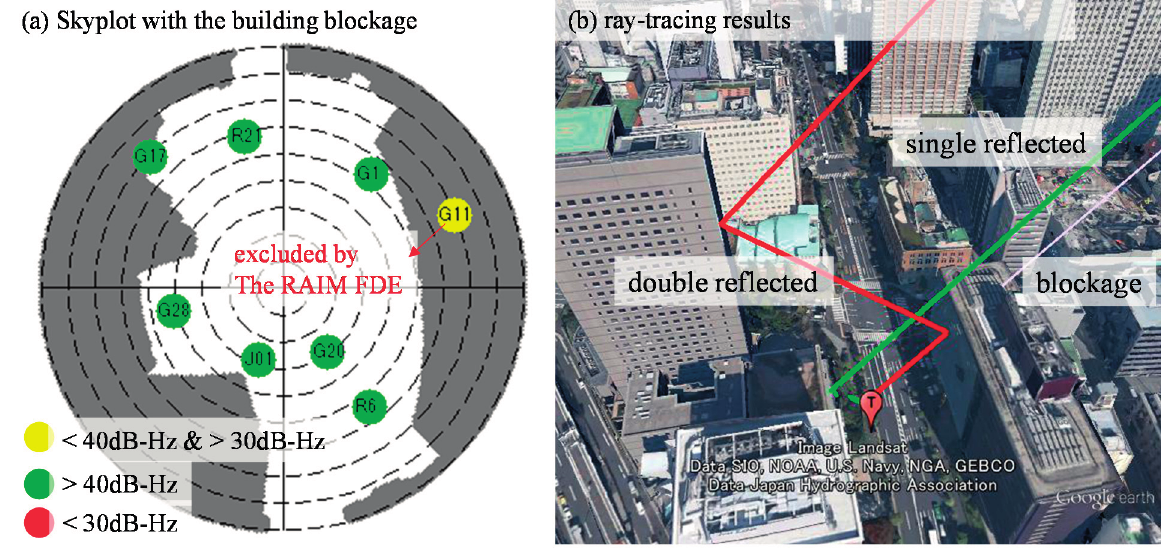
Figure 9. ( a ) Skyplot of point 264,239, and the dark grey color indicates the view blocked by surrounding buildings; ( b ) Ray-tracing result of point 264,239 based on the ground truth